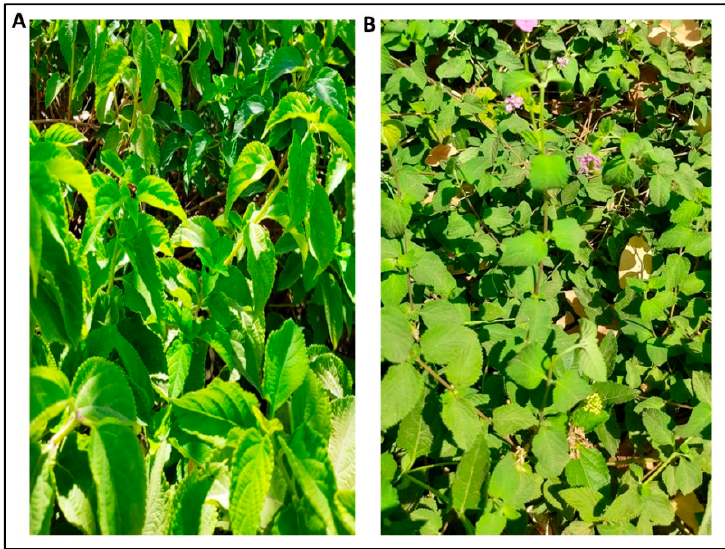
Figure 9. Photos of the collected fresh leaves of L. camara ( A ) and L. montevidensis ( B